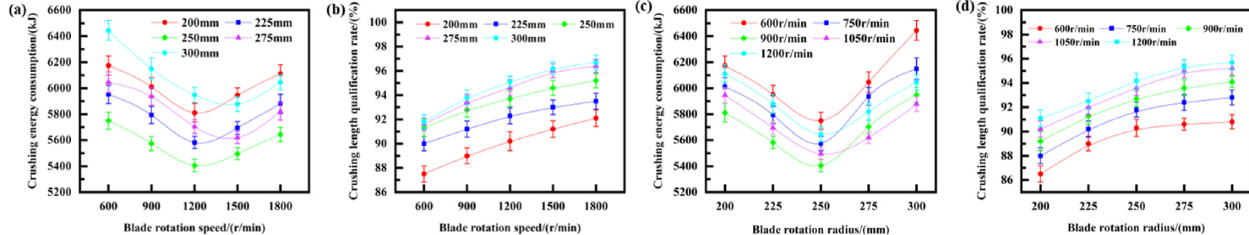
7 of 14 Figure 3. Soil bin test procedure. ( a ) Test equipment linking method. ( b ) Cutting energy consumption test data output. ( c ) Manual test results of crushing length qualification rate.